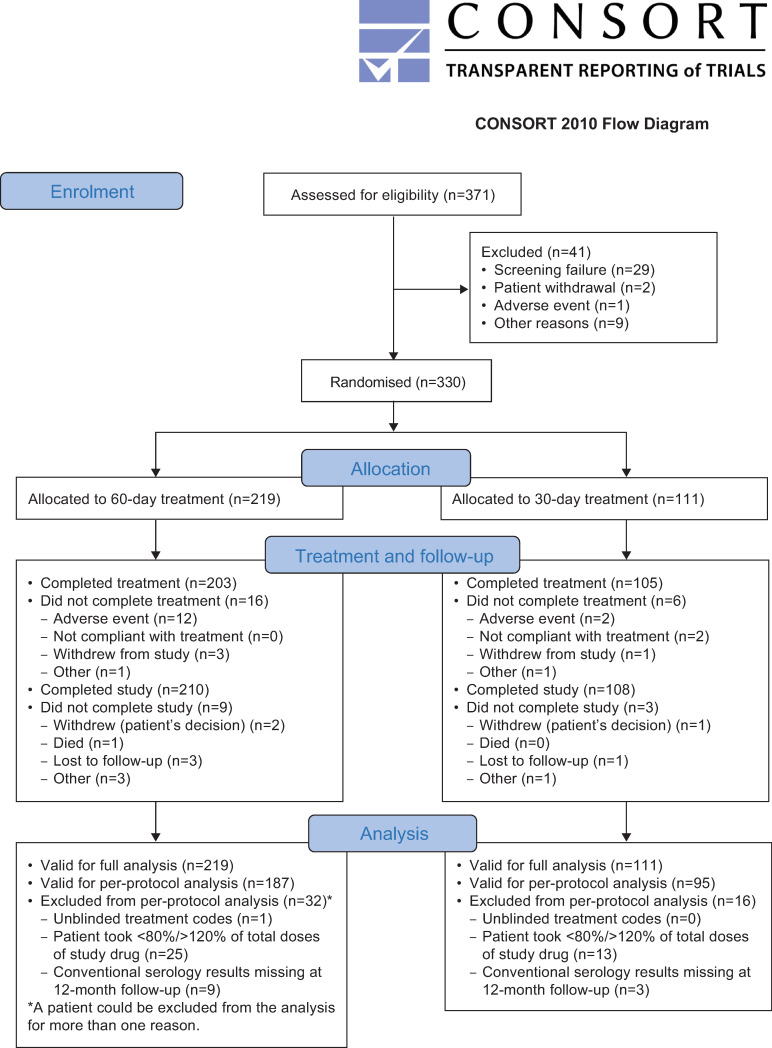
Patient disposition.